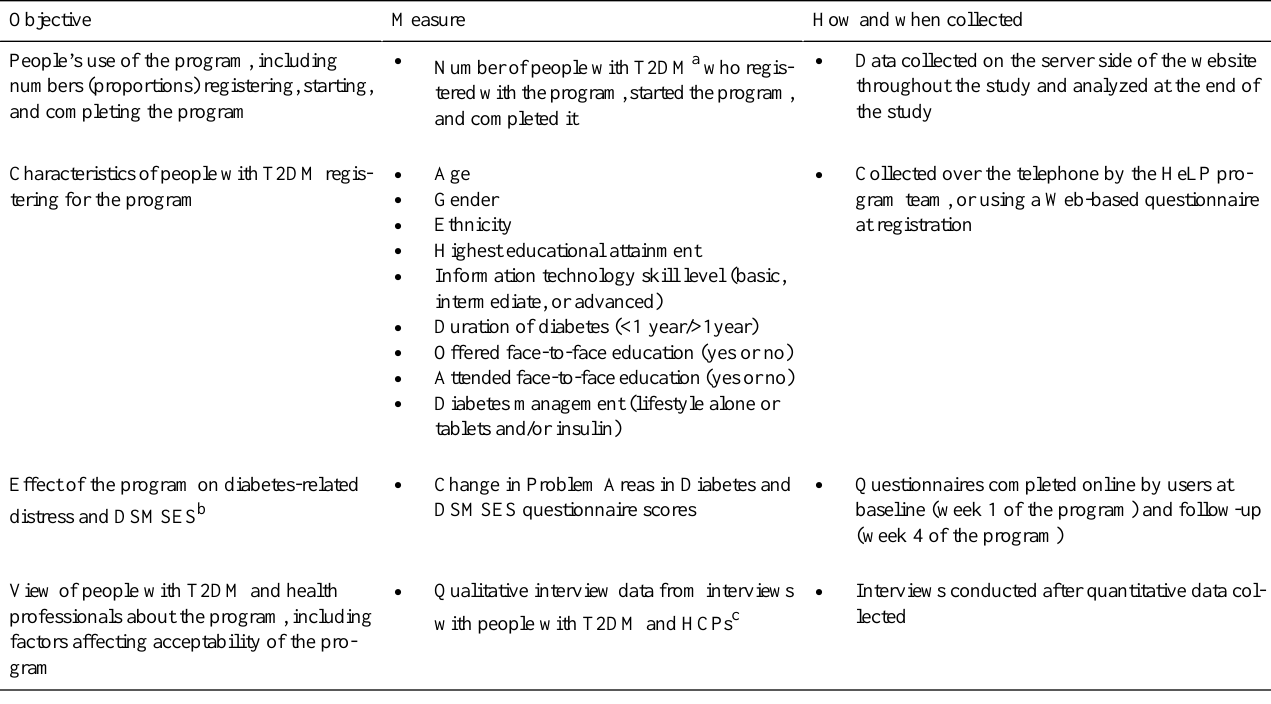
How and when collectedMeasureObjective